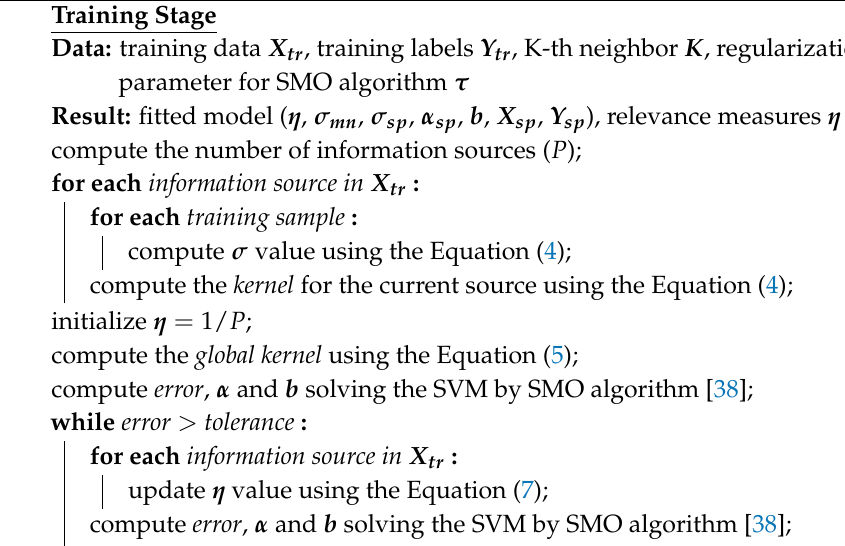
Algorithm 3: Data reduction by the mean of σ values related to the samples nearest to the support